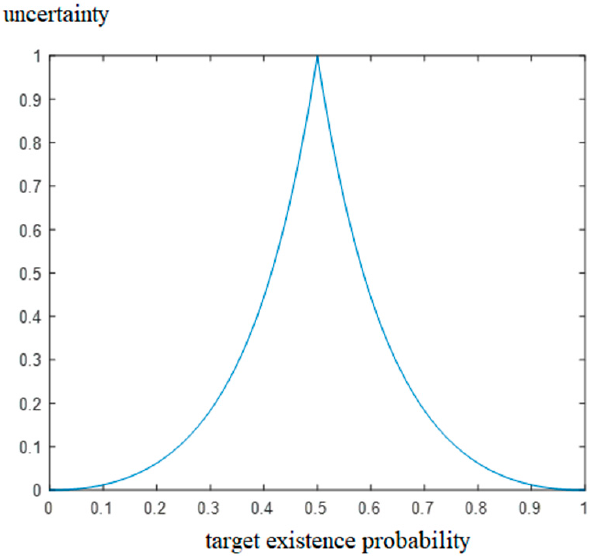
Figure 5. Relationship between uncertainty and target existence probability.